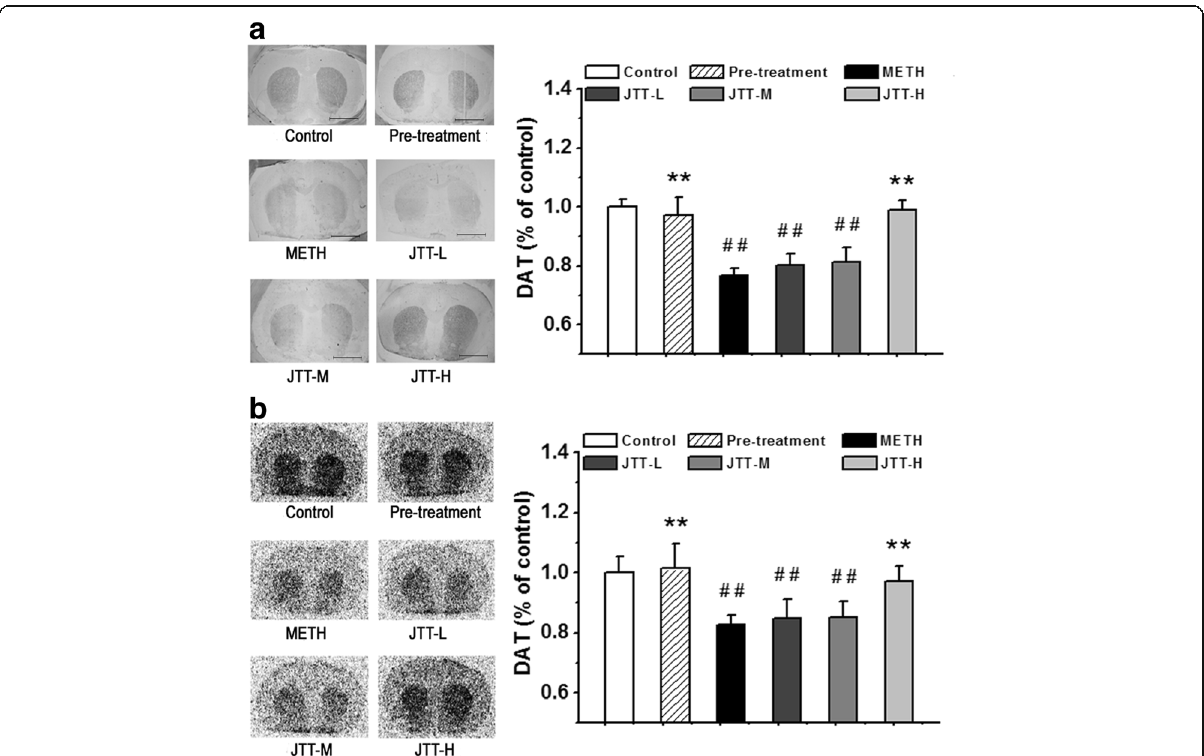
Fig. 2 Effect of Jitai tablet (JTT) on dopamine transporter (DAT) levels in the striatum as assayed by immunohistochemical staining ( a ) (Bar=5.00 mm) and autoradiography with [ 99m Tc]TRODAT-1 ( b ). Results of the two methods are accordant with each other. The remarkable reduction of DAT binding in the striatum induced by methamphetamine (METH) administration was significantly inhibited by JTT pre-treatment, or attenuated by post-treatment with high dose of JTT (JTT-H). Data are expressed as mean±SD ( n =5). METH group vs. control group: # p <0.05, ## p <0.01; JTT treatment group vs METH group: * p <0.05, ** p